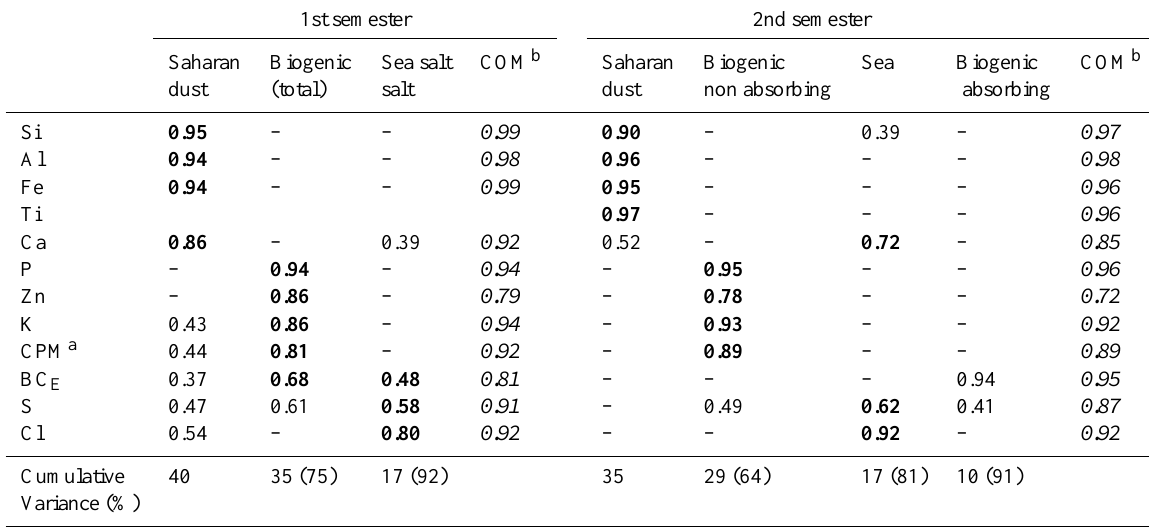
Table 3. The same as Table 2, but for the coarse mode aerosols*. Ti in the 1st semester was not included due to insufficient samples above detection limits to perform component analysis.